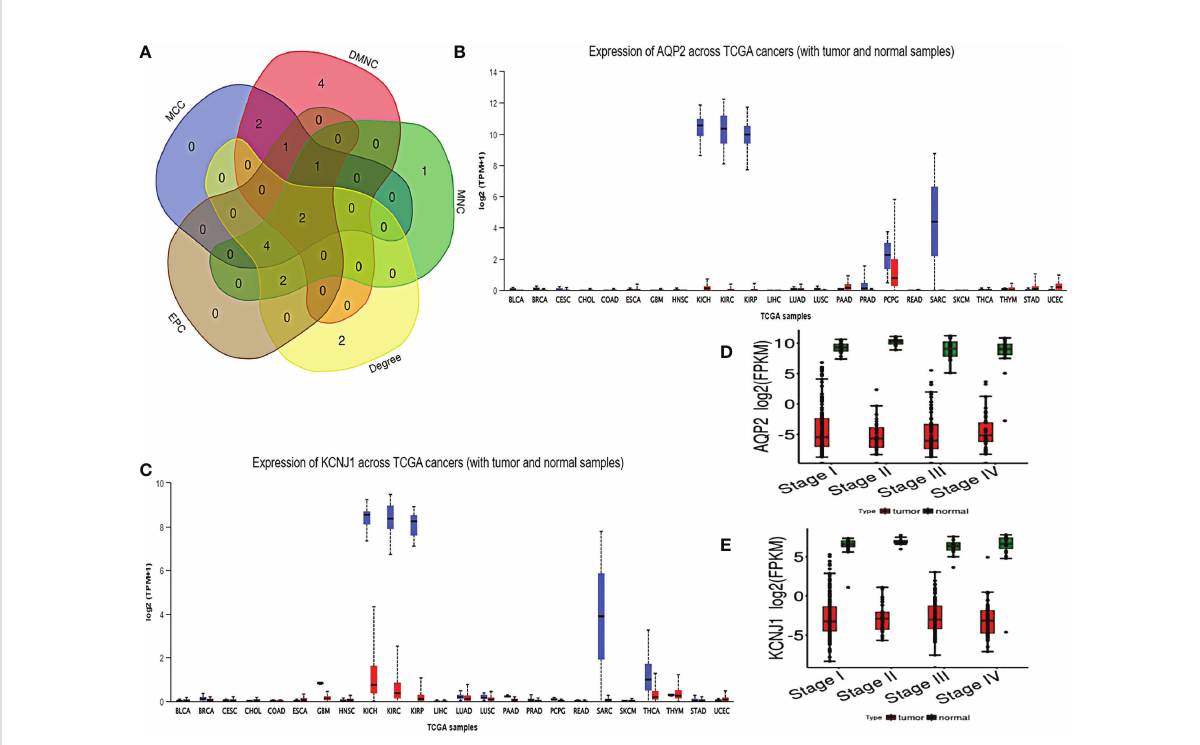
FIGURE 6 (A) using cytohubba plug-in to carry out fi ve algorithms for hub genes, and select the top 10 genes for veen diagram analysis. (B, C) Pan cancer analysis of AQP2 and KCNJ1. (D, E) expression of AQP2 and KCNJ1 in various stages of